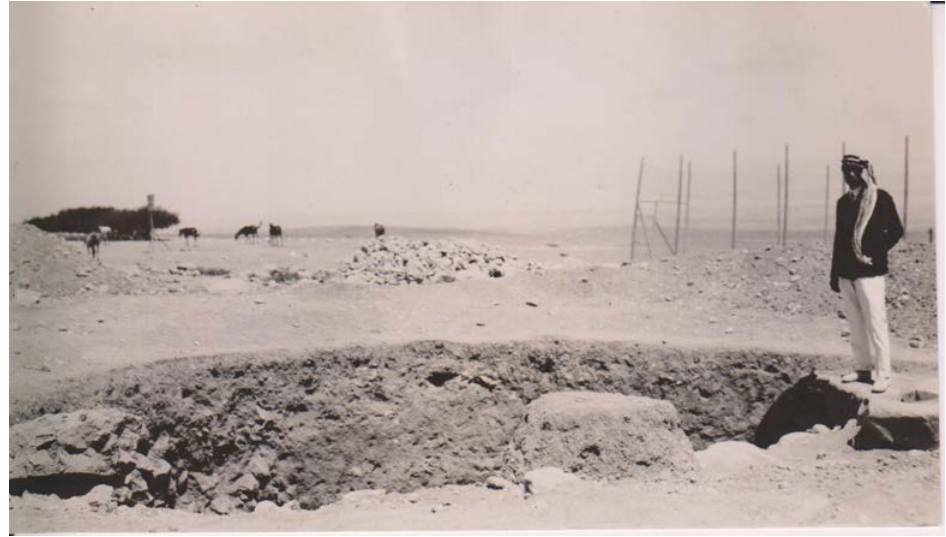
Fig. 8: A photograph in the Horsfield archive of Ali at Irbid, Transjordan. (Copyright UCL Institute of